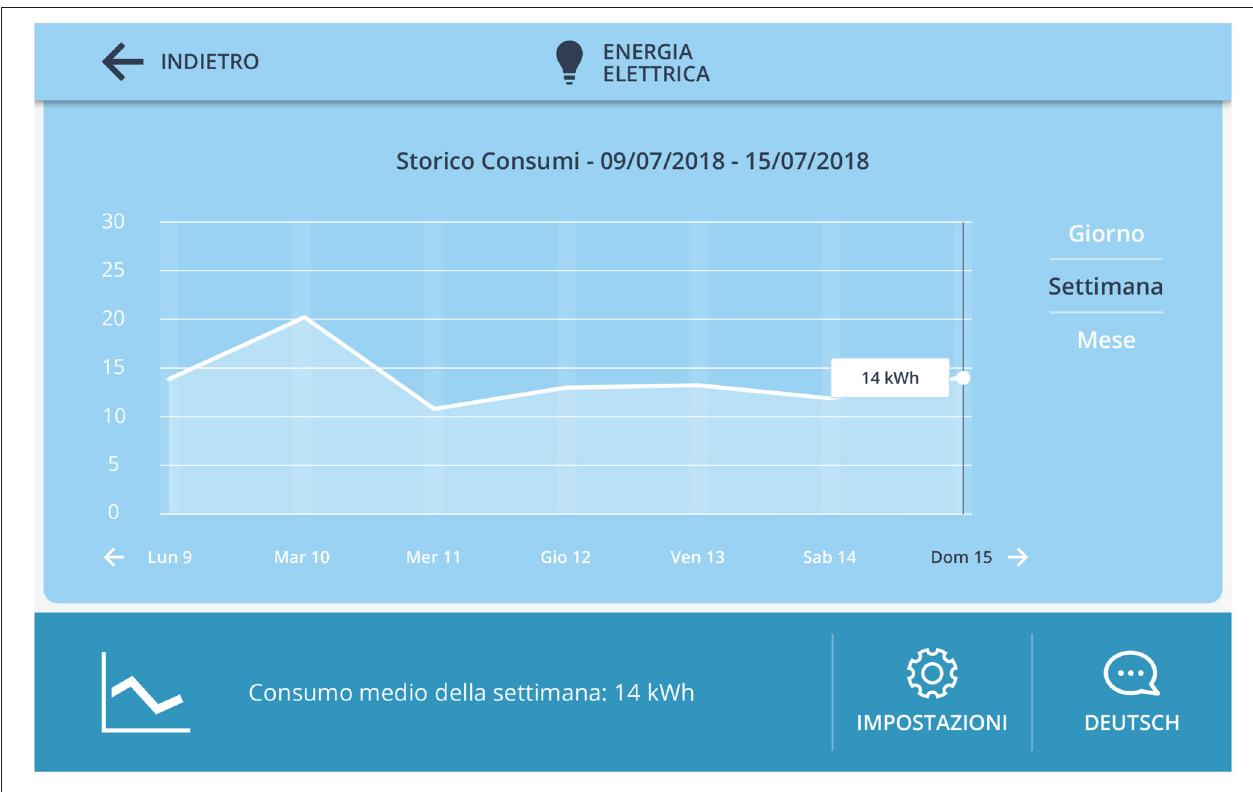
FIGURE 2 | Control group history